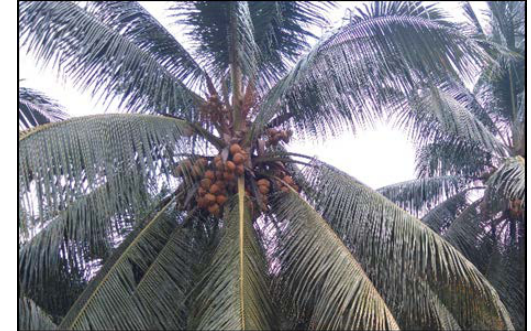
Figure 14. Coconut Size Not Effect to Coastline